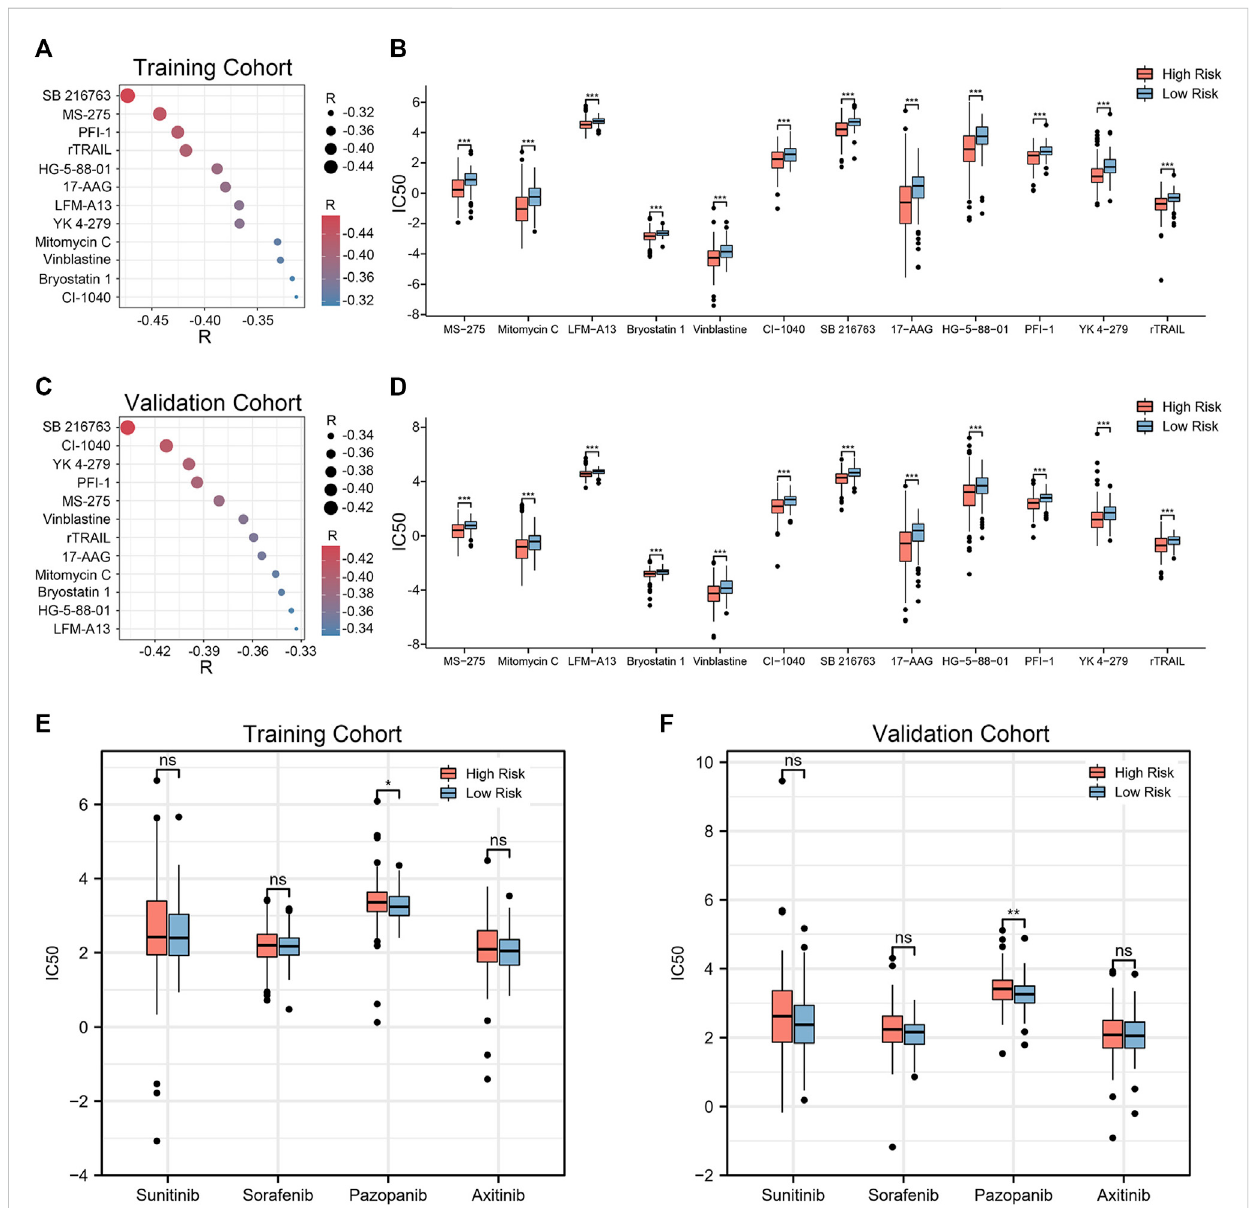
FIGURE 8 Twelve drug agents were identi fi ed as well as four VEGFR inhibitors for analysis. (A, C) Correlation between riskscore and the IC50 estimates for the 12 agents. The correlation was examined using Spearman correlation analysis. (B, D) Differences in the estimated IC50 for 12 agents between the high- and low-risk groups. (E, F) Comparison of IC50 estimates of four VEGFR targeted drugs (sunitinib, sorafenib, pazopanib and axitinib). The signi fi cance of the difference was tested with Wilcoxon test. * p < 0.05, ** p < 0.01, and *** p <